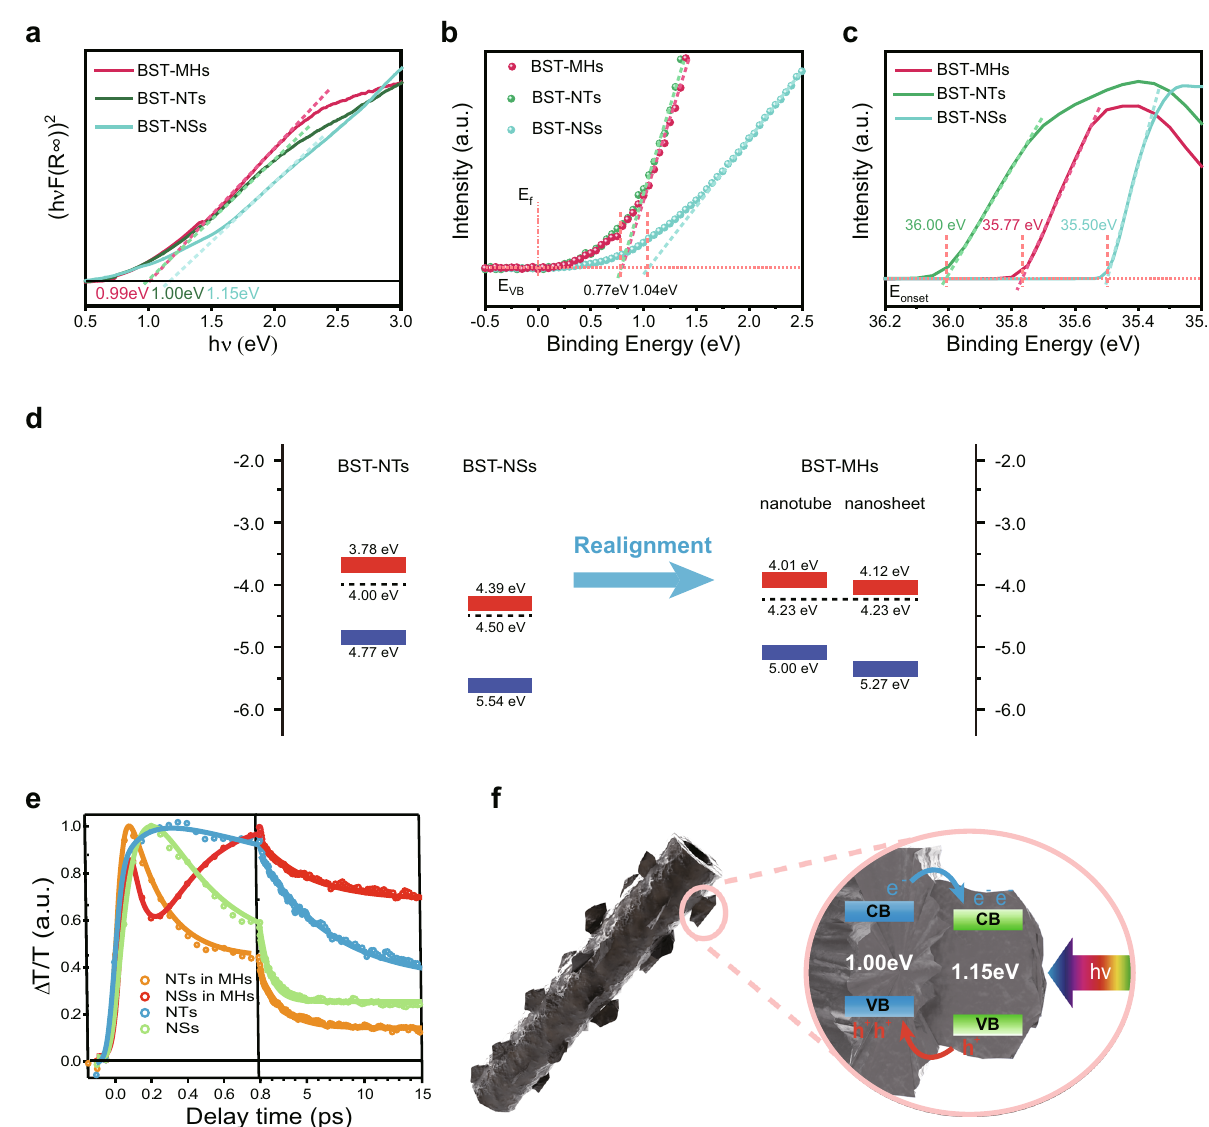
Fig. 2 Spectroscopic characterization and schematic energy band diagrams. a Tauc plots of BST-MHs, BST-NTs, and BST-NSs derived from UV-Vis diffuse re fl ectance spectra. b UPS spectra of BST-NTs, BST-NSs, and BST-MHs, showing their relative energies between valence band maximum and Fermi level. c Onset level ( E onset ) of the UPS spectra for BST-MHs, BST-NTs, and BST-NSs, respectively. d Energy band diagrams of BST-NTs, BST-NSs, and BST- MHs. e Corresponding TA kinetics at B 1 and B 2 of BST-NTs, BST-NSs, and BST-MHs. The circles are experimental data and the solid lines are their exponential fi ts. f Schematic of charge-separation processes in BST-MHs under solar